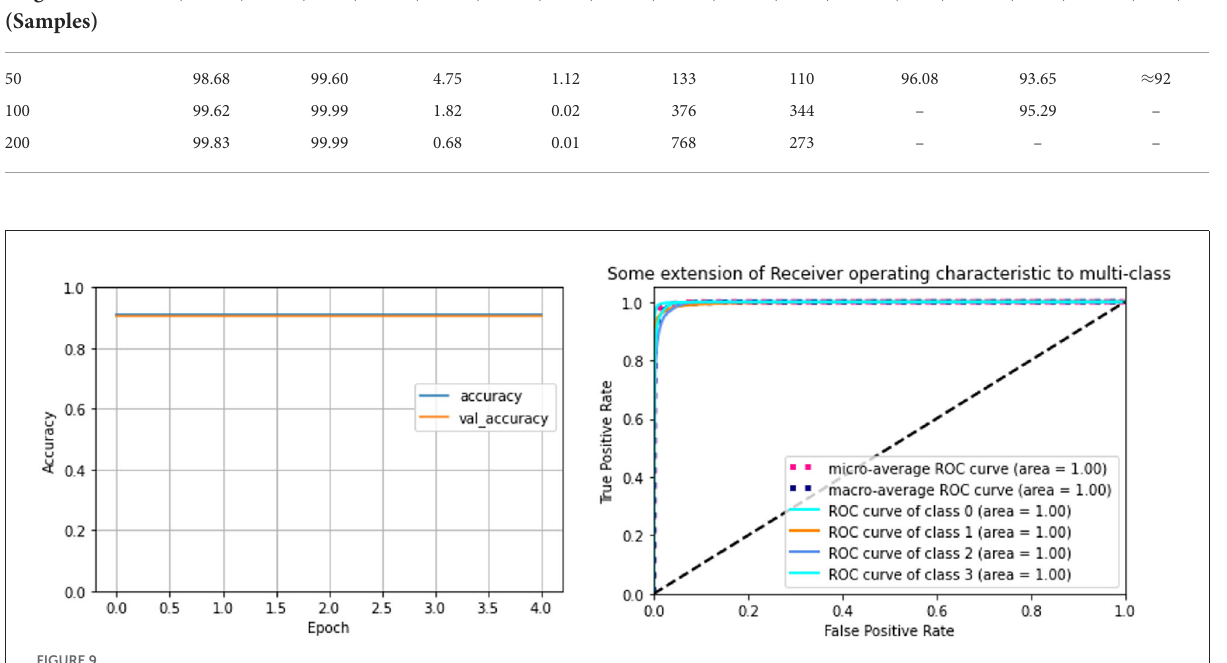
TABLE 3 The overage accuracy, loss, and computation delay of the long short-term (LSTM) and the computational neural network (CNN) models with different window sizes. Window length